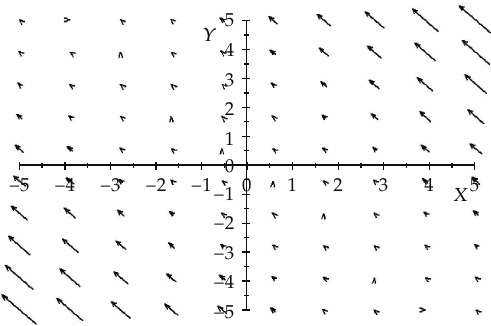
Figure 4: The phase diagram basis for S (cid:2) X,Y (cid:3)